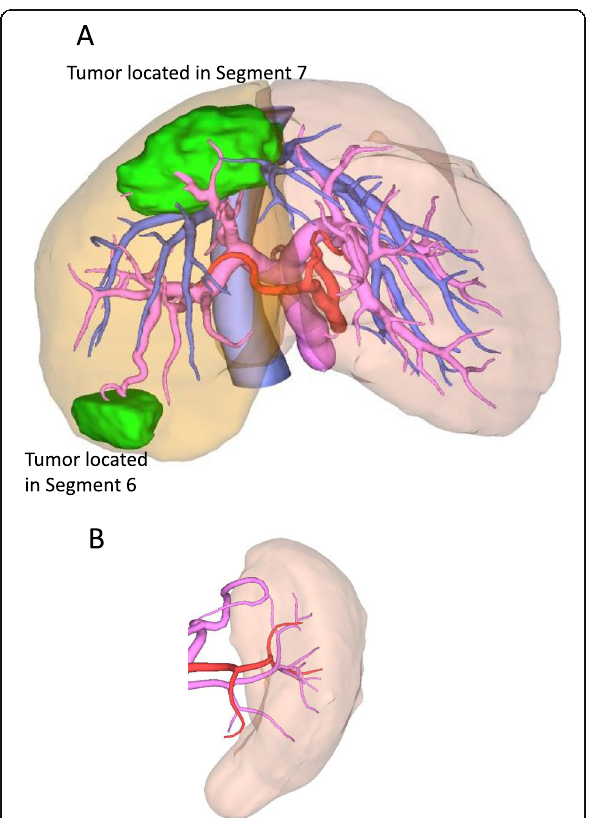
Fig. 4 Three-dimensional CT volumetry. a After right-hepatic resection, the remnant liver volume was 867 mL (59.4%). b Spleen volume at the first visit was 428 mL. CT, computed